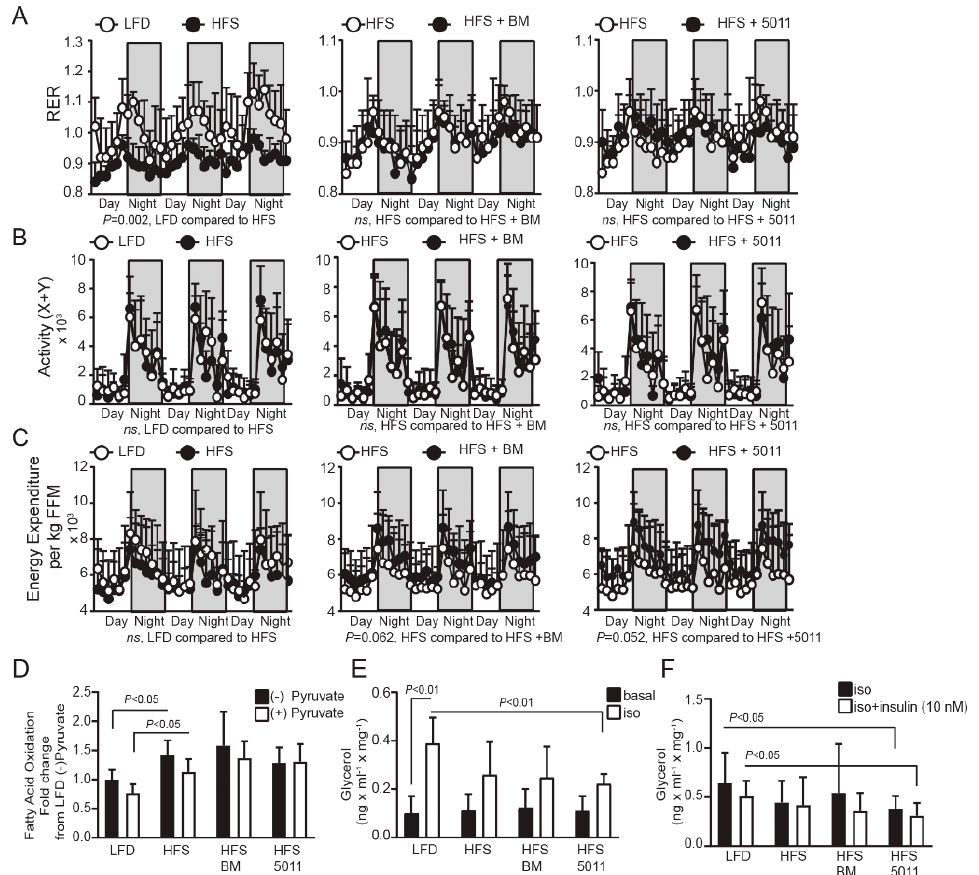
Figure 3. Effects of HFS diet and botanical supplementation on substrate utilization in vivo and ex vivo in skeletal muscle and adipose tissue. The respiratory exchange ratio (RER) ( A ) reflects a shift toward fatty acid oxidation with HFS diets that was not altered by botanical supplementation. Activity ( B ) and energy expenditure ( C ) were not altered by diet. Fatty acid oxidation (FAO) was measured ex vivo in skeletal muscle ( D ) in the presence and absence of pyruvate to assess the impact of diet on substrate switching and metabolic flexibility in skeletal muscle. Adipose tissue explants were exposed to adrenergic stimulation by isoproterenol ( E ) and lipolytic rates were measured. Isoproterenol-induced lipolysis was reduced in the HFS compared to that in the LF controls, and the blunted response was accentuated by PMI5011 supplementation. Adipose tissue explants were treated with isoproterenol + or – insulin ( F ) to determine insulin suppression of lipolytic rate. HFS-fed mice supplemented with PMI5011 showed enhanced insulin-mediated suppression of lipolysis. Statistical significance was set at p < 0.05, ( n = 10 per group), variability is expressed as mean ± SD.